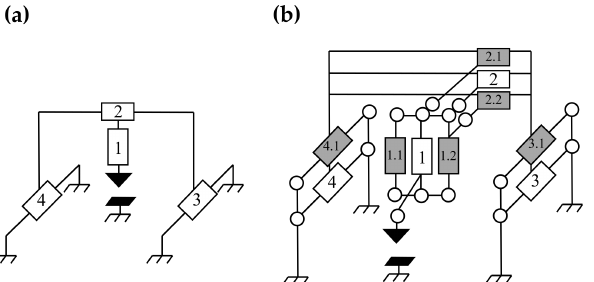
Figure 4. Practical implementation of a Cartesian system. Panel ( a ) shows a functional kinematic scheme of a Cartesian gantry CNC machine and panel ( b ) gives a detailed kinematic scheme of its implementation with actuated prismatic joints (shown with white rectangles) and passive rail guides (shown with grey rectangles). Circles denote passive spherical joints with internal stiffeners, a black triangle denotes the printhead, and a black parallelepiped denotes the